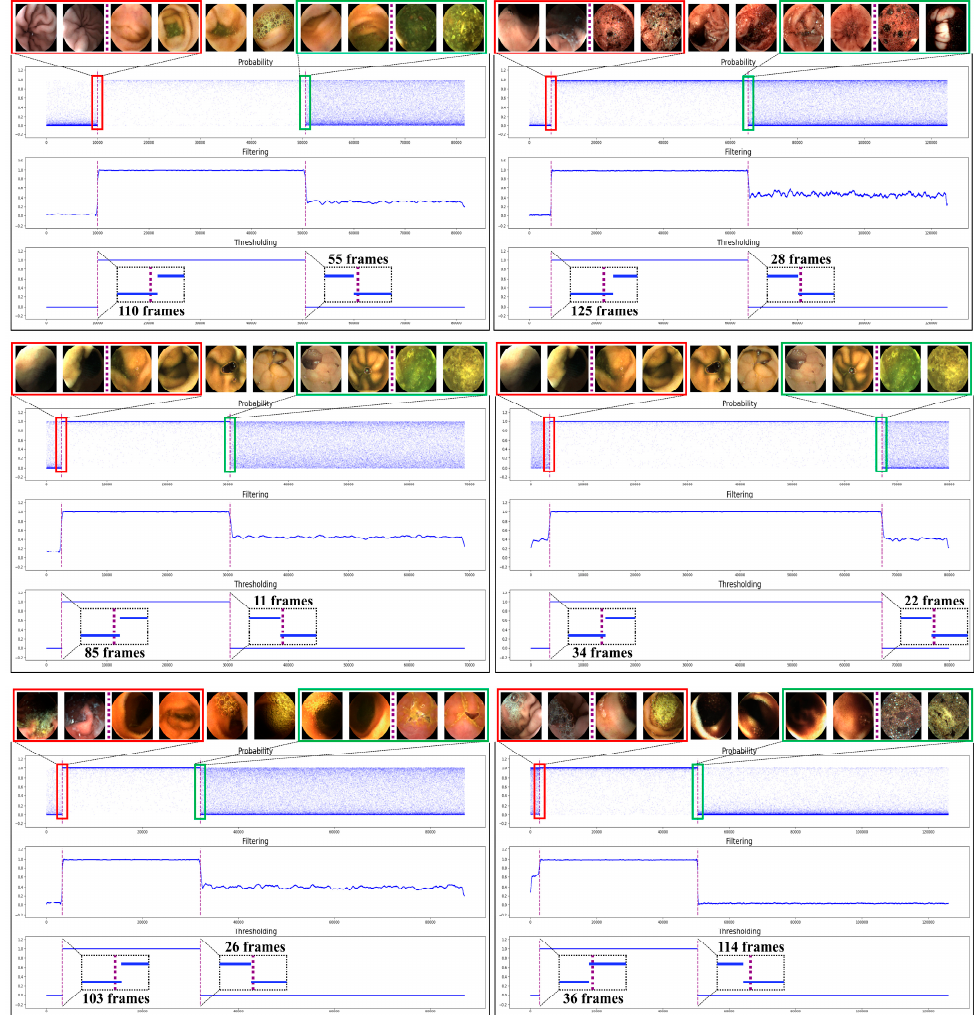
Figure 4. Qualitative results of the proposed small bowel detection method from six cases. Please refer to the supplementary material to see the results from all test